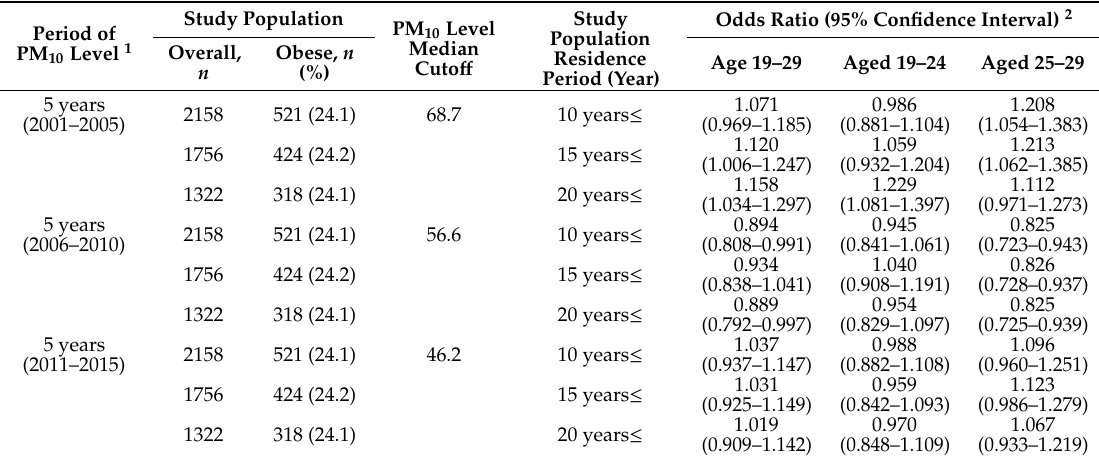
Table 3. Associations between obesity and exposure to high level of PM 10 according to residence period among young adults in Seoul, Korea,